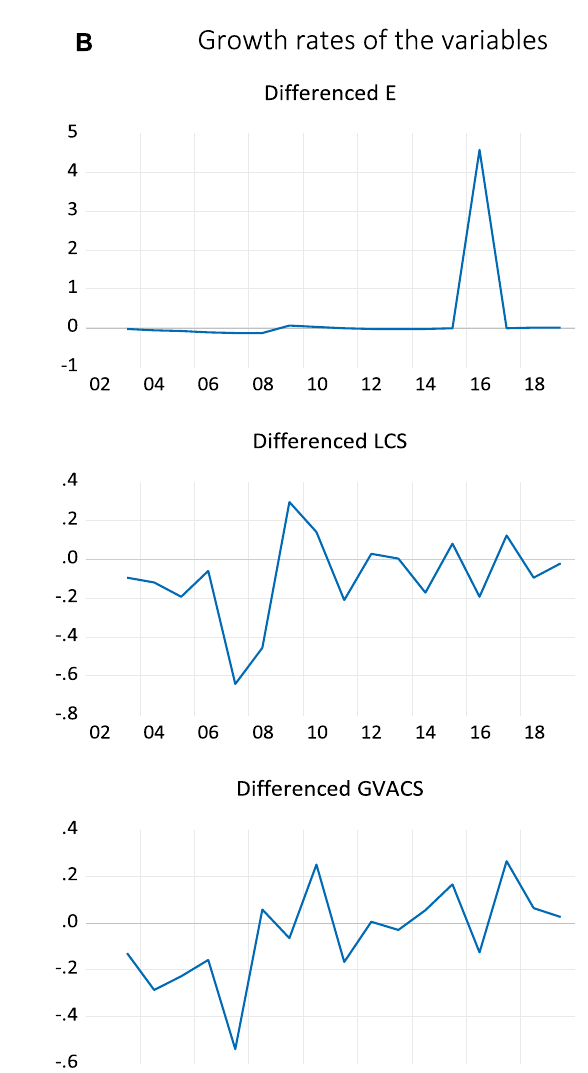
FIGURE 1 Time pro fi le of the